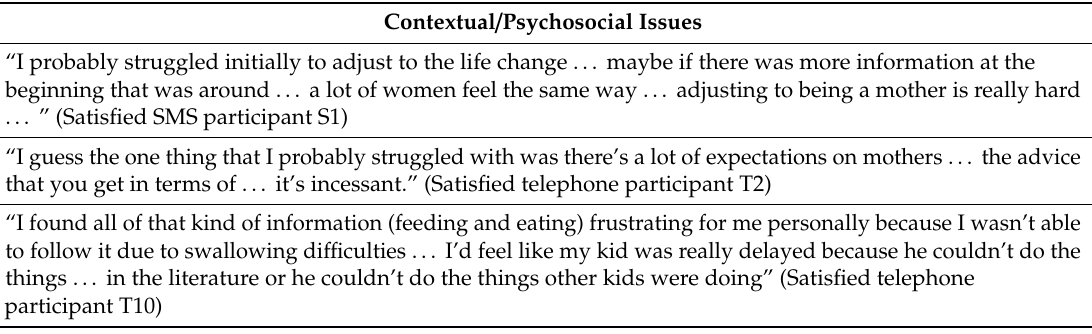
Table 8. Quotes underpinning participants’ contextual / psychosocial